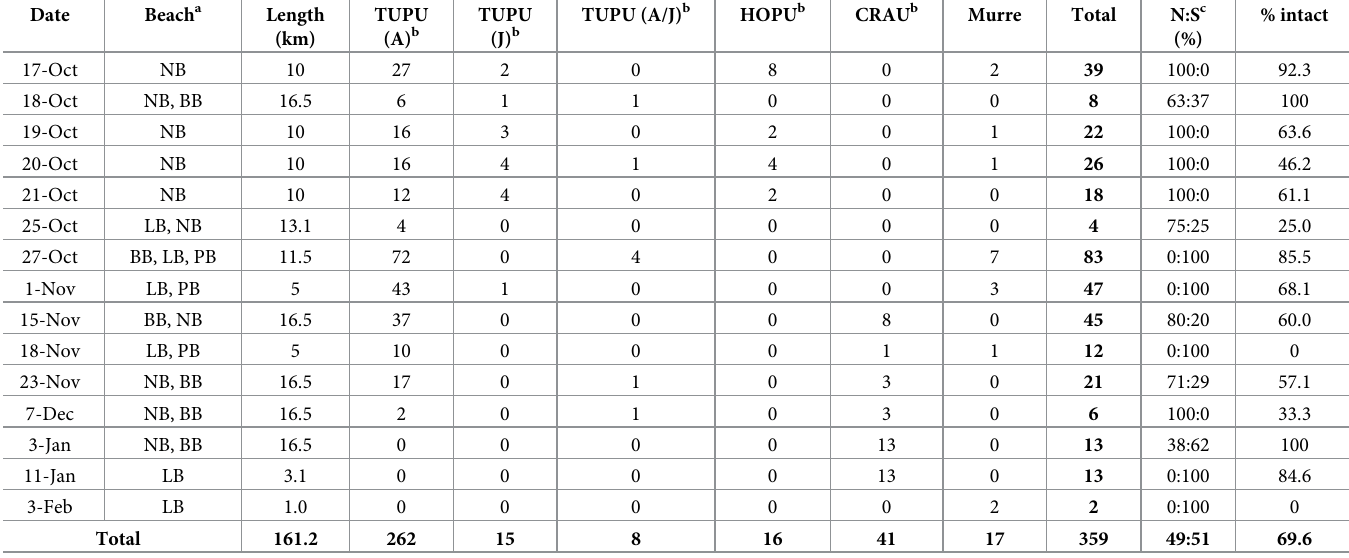
Table 1. Observed counts made on St. Paul Island, Alaska, from October 2016 through to January